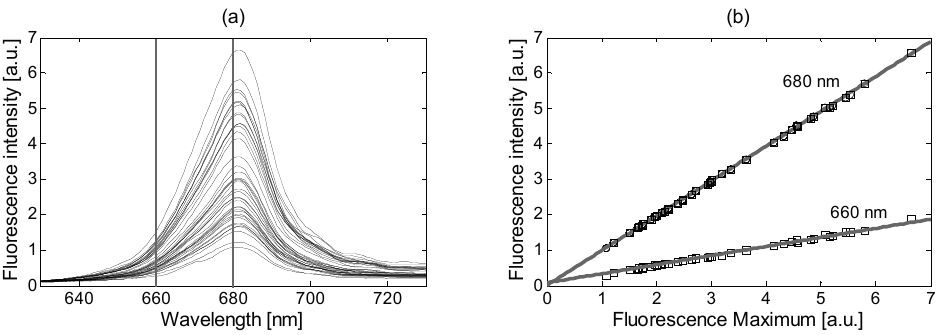
Figure 2. Schematic diagram of the three steps of the wavelet method: multilevel decomposition, thresholding, and multilevel reconstruction. Thresholding is obtained via ( a ) soft threshold techniques or ( b ) hard threshold